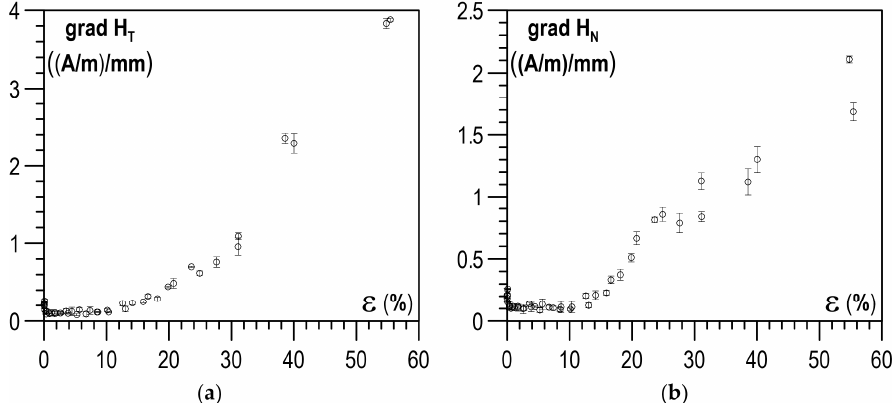
Figure 9. Relation between the mean gradient value and the plastic deformation degree: ( a ) mean gradient of tangential component grad H T ; ( b ) mean gradient of normal component grad H N .